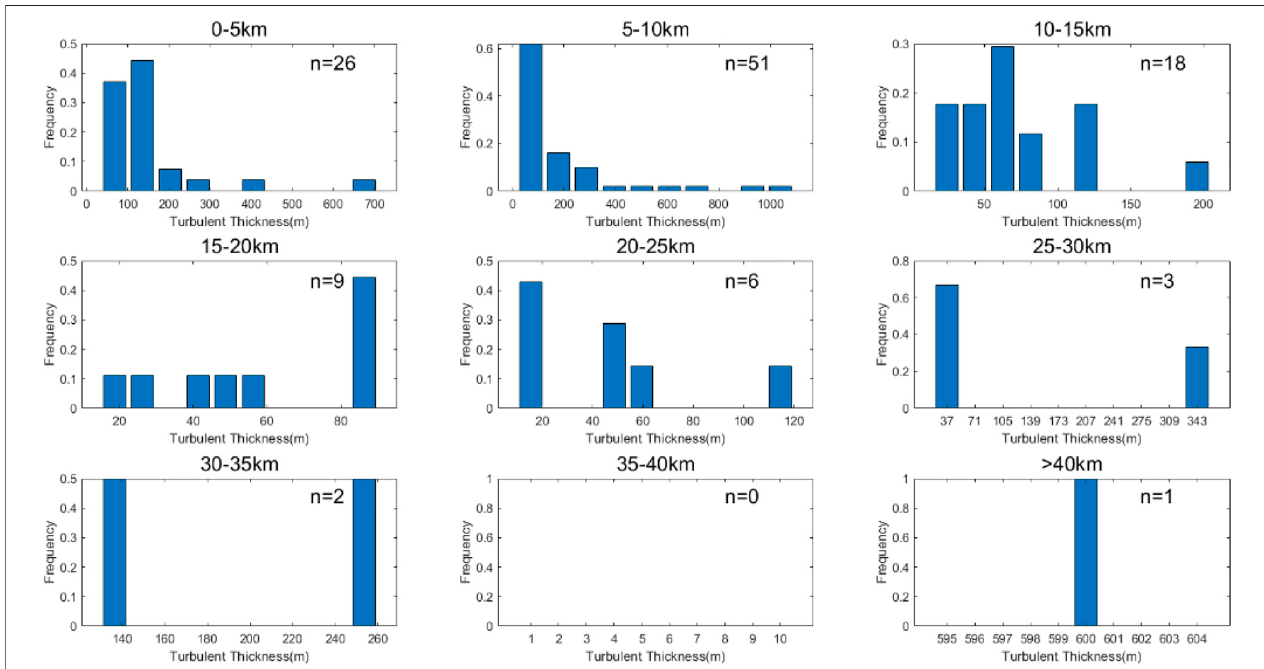
FIGURE 7 | Histogram of frequency distribution of turbulence thickness per 5 km height for seven sets of sounding data from January 10 to 14.